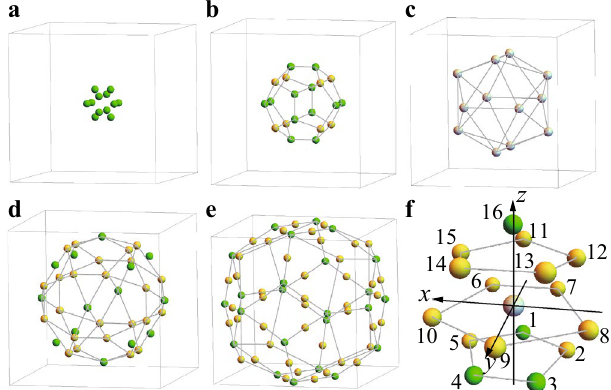
Figure 1. Crystal structure of Tsai-type cluster and local atomic configuration. Tsai-type cluster consists of ( a ), the cluster center, ( b ), dodecahedron, ( c ), icosahedron, ( d ), icosidodecahedron, and ( e ), defect rhombic triacontahedron with Au (yellow), Au/Si (green), and Tb (gray). ( f ), Local atomic configuration around Tb. (This figure is created by using Adobe Illustrator CS5 Version